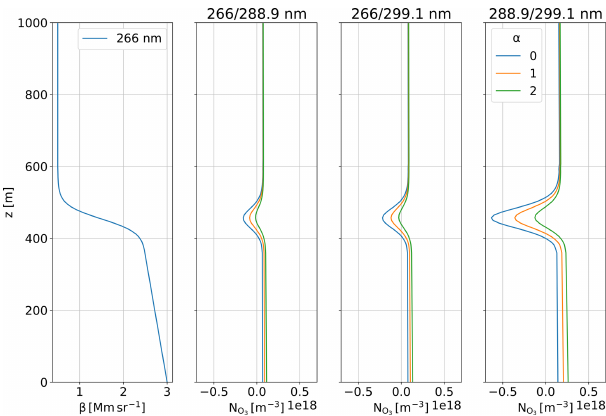
Figure 5. Aerosol error contribution (differential backscatter and extinction contributions) based for the different available DIAL wavelength pairs and three different Ångström exponents ( α